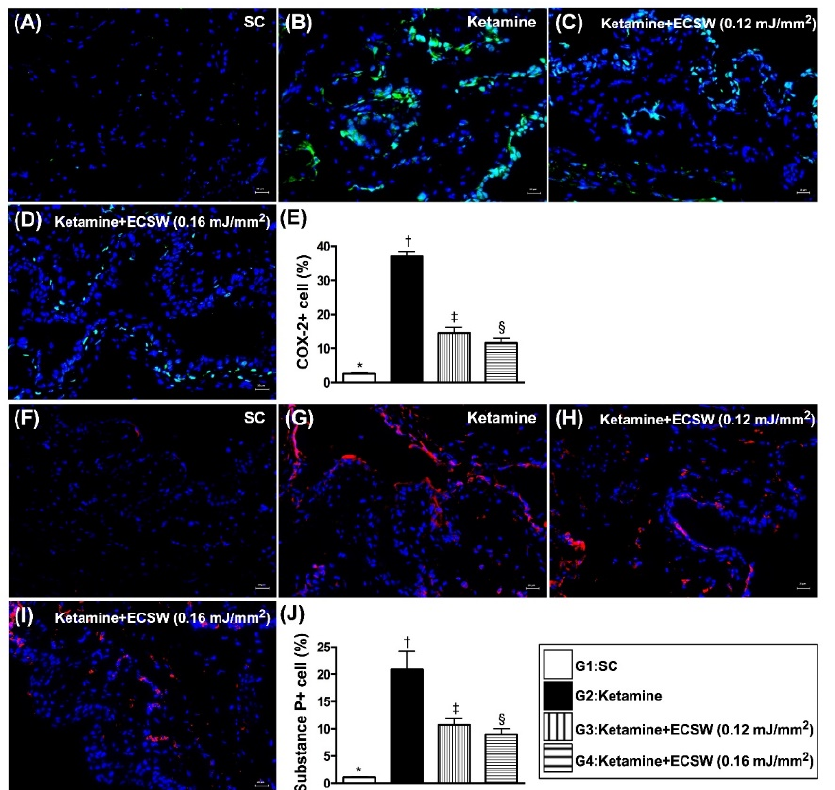
Figure 7. ECSW therapy reduced the ketamine-induced inflammatory cell infiltration in rat urinary bladder by day 42 after ketamine administration. ( A – D ) Illustrating the immunofluorescent (IF) microscopic finding (400 × ) for identification of positively-stained COX-2 cells (green color). ( E ) Analytical result of percentage of COX-2+ cells in high-power field, * vs. other groups with different symbols (†, ‡, §), p < 0.0001. ( F – I ) Illustrating the IF microscopic finding (400 × ) for identification of positively-stained substance P cells (red color). ( J ) Analytical result of percentage of substance P+ cells in high-power field, * vs. other groups with different symbols (†, ‡, §), p < 0.0001. Scale bar in right lower corner represents 20 μ m. All statistical analyses were performed by one-way ANOVA, followed by Bonferroni multiple comparison post hoc test ( n = 6 for each group). Symbols (*, †, ‡, §) indicate significance (at 0.05 level). ECSW = extracorporeal shock wave.